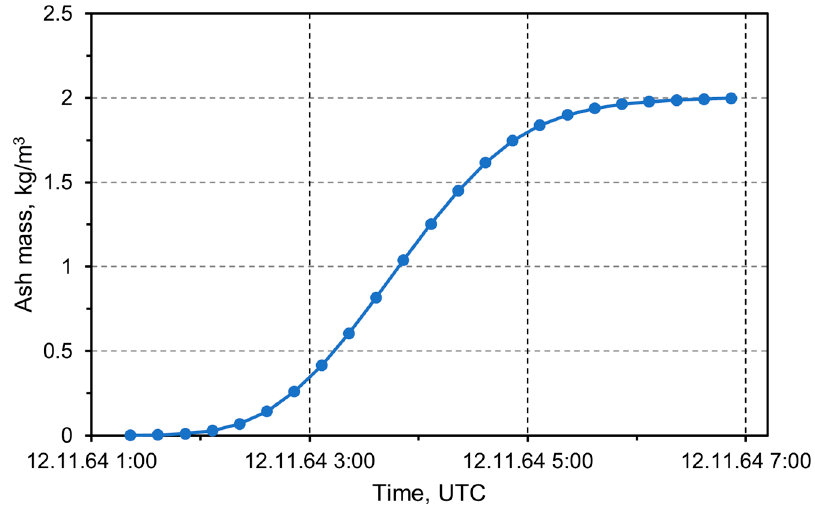
Figure 12. The distribution of the fallen ash mass over the time in Nikolskoye calculated through